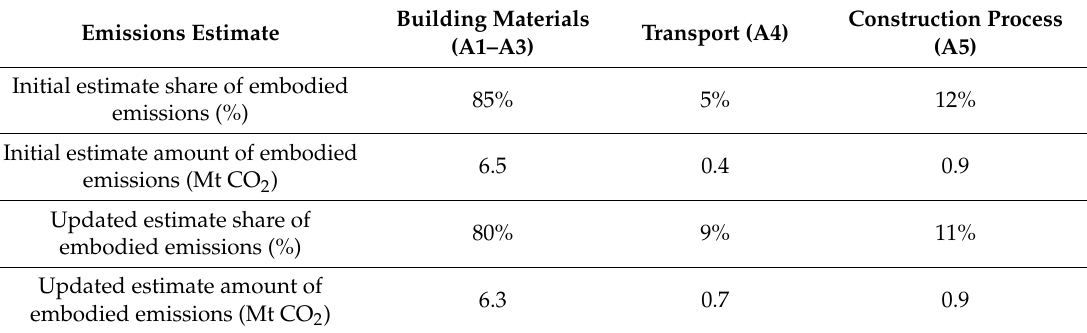
Table 3. Initial and updated annual emissions estimates per lifecycle stage for building construction in the base year of